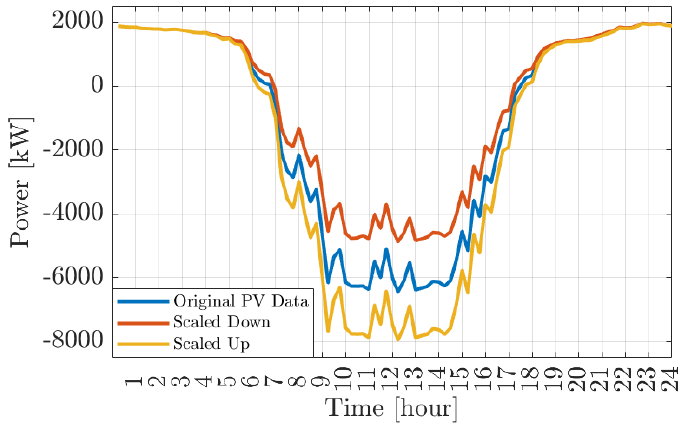
Figure 13. Dispatch plan with scaled PV generation time